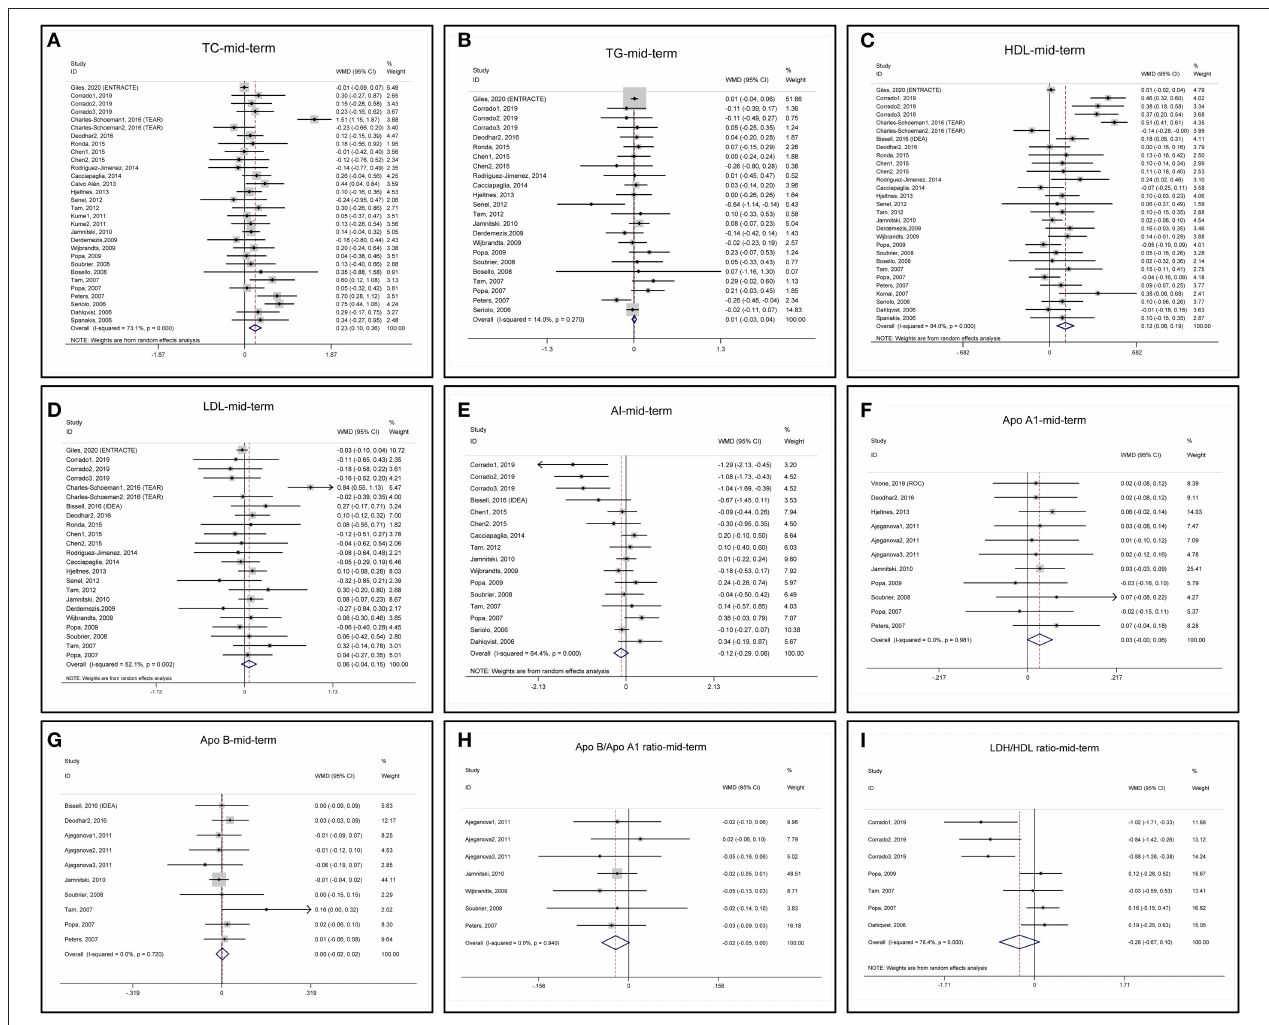
FIGURE 3 | Forest plots of meta-analyses of the mid-term changes in (A) TC, (B) TG, (C) HDL, (D) LDL, (E) AI, (F) ApoA1, (G) ApoB, (H) ApoB/ApoA1 ratio, and (I) LDL/HDL